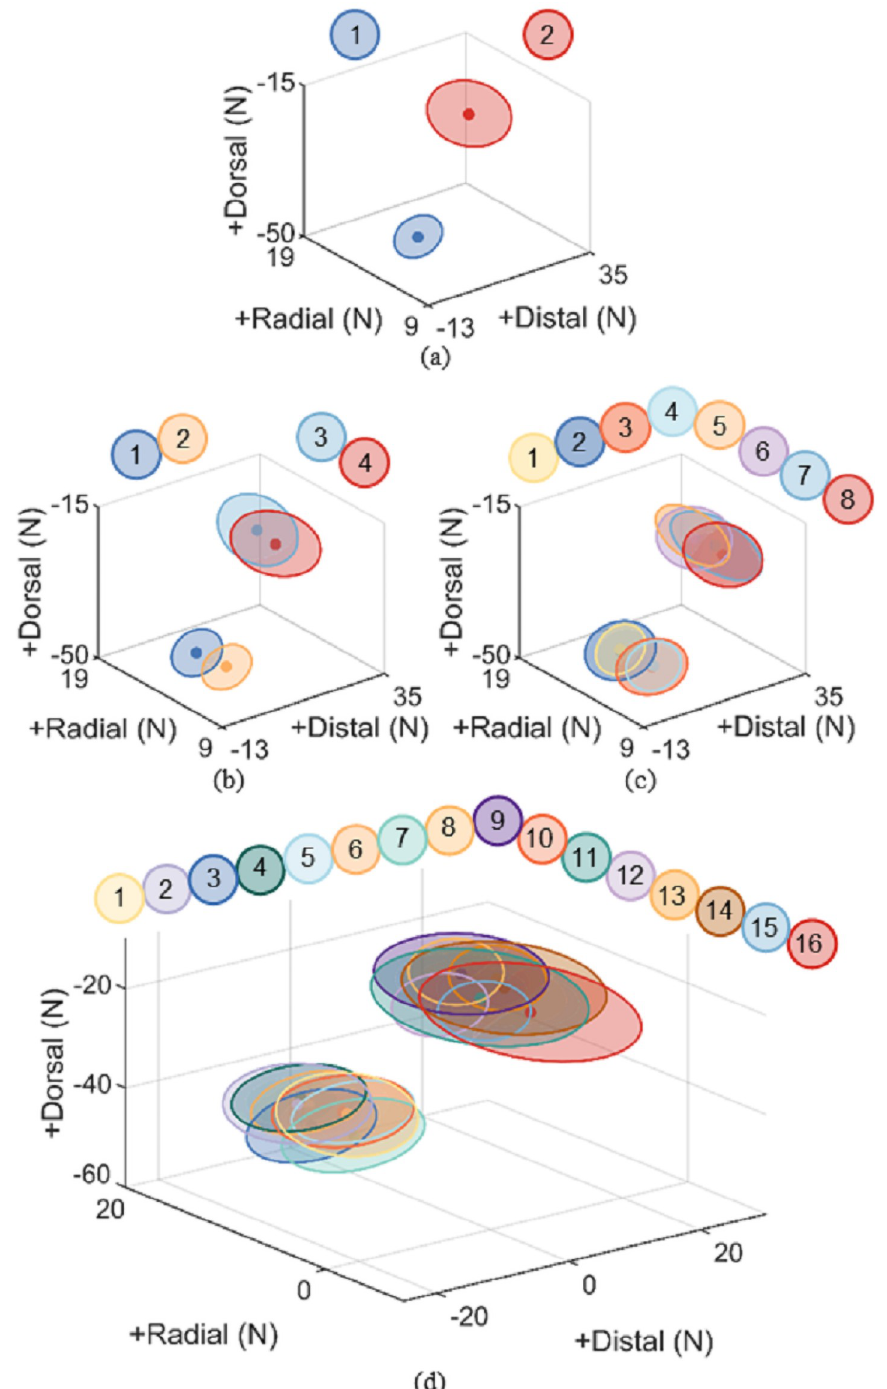
Fig 3. Peak thumb-tip forces across all datasets. (a)-(d) represent peak thumb-tip forces achieved in simulations from Datasets 1–4, respectively. Numbers above graphs correspond to each labeled group, which are described in Table 4. Ellipsoid centers represent mean force achieved for each labeled group. Ellipsoid radii represent 1 standard deviation from the mean. As datasets incorporate changes to more thumb muscles, the final thumb-tip forces achieved overlap more frequently across labeled groups. This increased overlap results in a more challenging classification task for each neural network model.